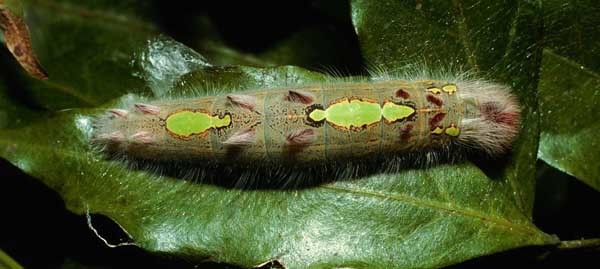
Morpho
p.
catalina voucher n. 02-SRNP-8076, feeding on Fabaceae. Image voucher n. DHJ66311.jpg